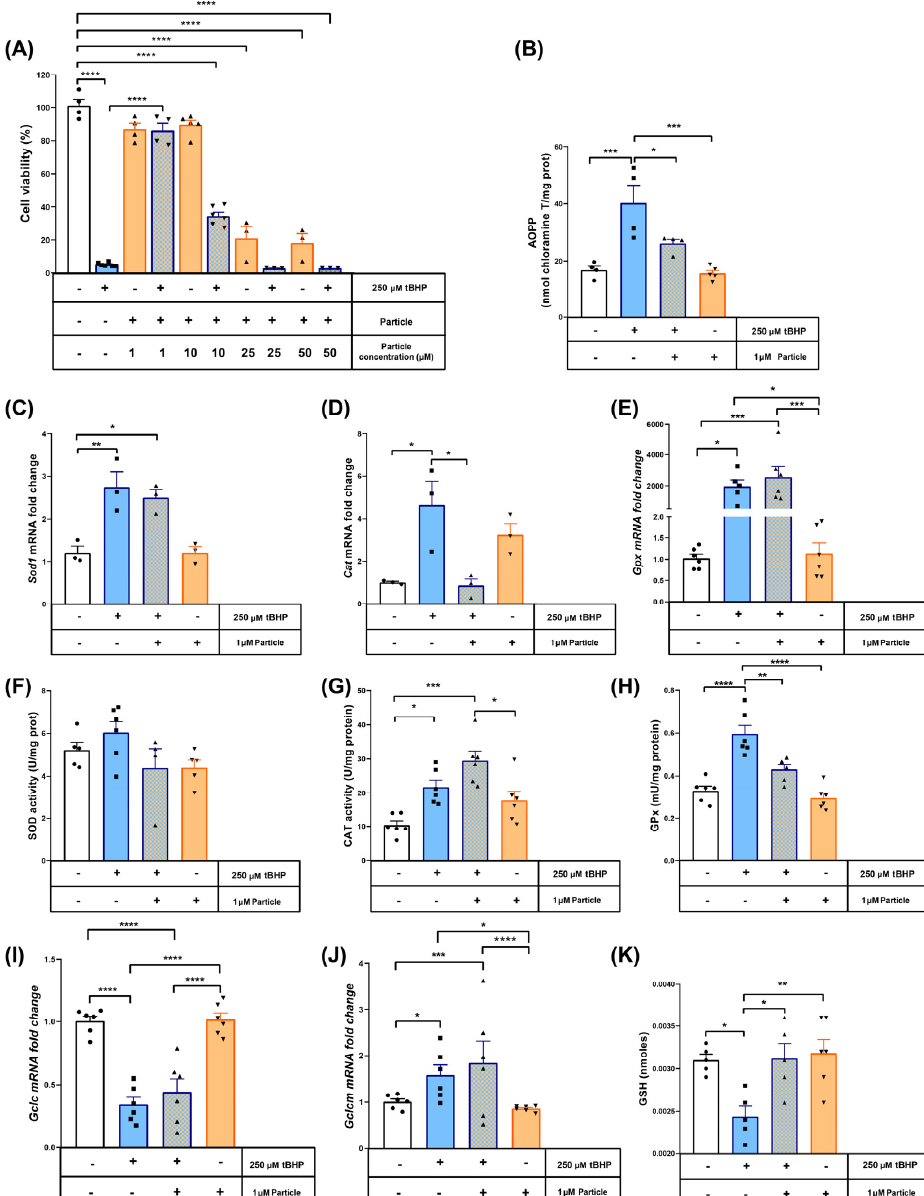
Figure 8. Cytoprotective and antioxidant role of myrtle particles in murine macrophage cell lines. ( A ) Viability of the cells treated with 250 μ M tBHP for 1 h according to MTT assay. Cytoprotective effect of the different concentrations of myrtle particles ranging from 1 to 50 μ M. Antioxidant properties at a concentration of 1 μ M myrtle particles ( B ) Advanced Oxidation Protein Products (AOPPs). qPCR assays for genes encoding free radical scavenging enzymes: SOD1 ( C ), CAT ( D ) and GPX ( E ). The expression values represent four biological replicates and are shown relative to the β -Actin expression as a housekeeping gene. The mRNA levels of the control group for each gene were set at 1. Activity of the antioxidant enzymes superoxide dismutase ( F ), catalase ( G ) and glutathione peroxidase ( H ). ( I ) Reduced glutathione content. mRNA levels of the catalytic ( J ) and modifier ( K ) subunits of the Glutamate-cysteine ligase. The expression values represent four biological replicates and are shown relative to the β -Actin expression as a housekeeping gene. The mRNA levels of the control group for each gene were set at 1. The results are represented as the mean ± SEM. * p < 0.05; ** p < 0.01; *** p < 0.001; **** p < 0.0001. “+” (compound added) “–” (not added). Circles: control; squares: 250 μ M tBHP added; up triangle: co-treatment with tBHP + particle; down triangle: only particle treatment.